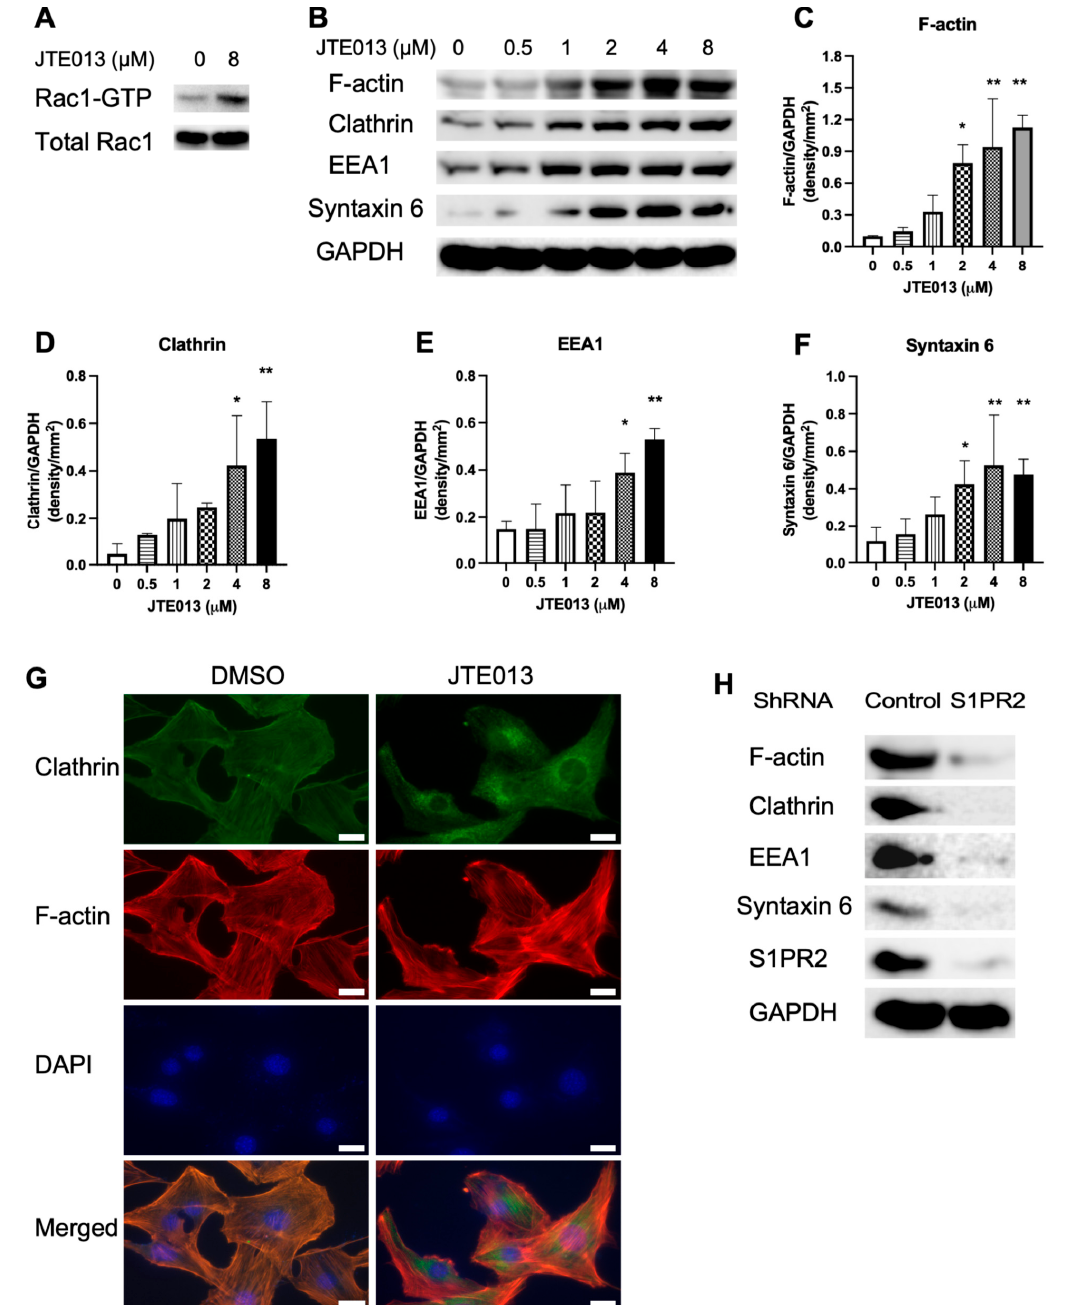
Figure 5. JTE013, but not a S1PR2 shRNA, increased vesicle trafficking-associated protein levels in murine BMSCs cultured in osteogenic media. Murine BMSCs were cultured in osteogenic media with either vehicle (DMSO) or JTE013 for 9 days. Proteins were harvested 20 min (for Rac1) or 30 min (for other proteins) after changing osteogenic media with or without JTE013. ( A ) Rac1-GTP and total Rac1 in BMSCs. ( B ) F-actin, clathrin, EEA1, syntaxin 6, and GAPDH protein levels in murine BMSCs treated with DMSO or various doses of JTE013. Protein densitometry of ( C ) F-actin, ( D ) clathrin, ( E ) EEA1, and ( F ) syntaxin 6 in murine BMSCs treated with DMSO or JTE013 was normalized by GAPDH protein expression in BMSCs (n = 3, * p < 0.05, ** p < 0.01). ( G ) Representative images of immunofluorescence staining of clathrin, F-actin, and DAPI in murine BMSCs 30 min after changing with osteogenic media. The images were taken under 400 × magnification. The scale bars represent 20 µ m. ( H ) F-actin, clathrin, EEA1, syntaxin 6, S1PR2, and GAPDH protein levels in murine BMSCs treated with a control shRNA or a S1PR2 shRNA and cultured in osteogenic media for 9 days. Proteins were harvested 30 min after changing with osteogenic media with puromycin (1 µ